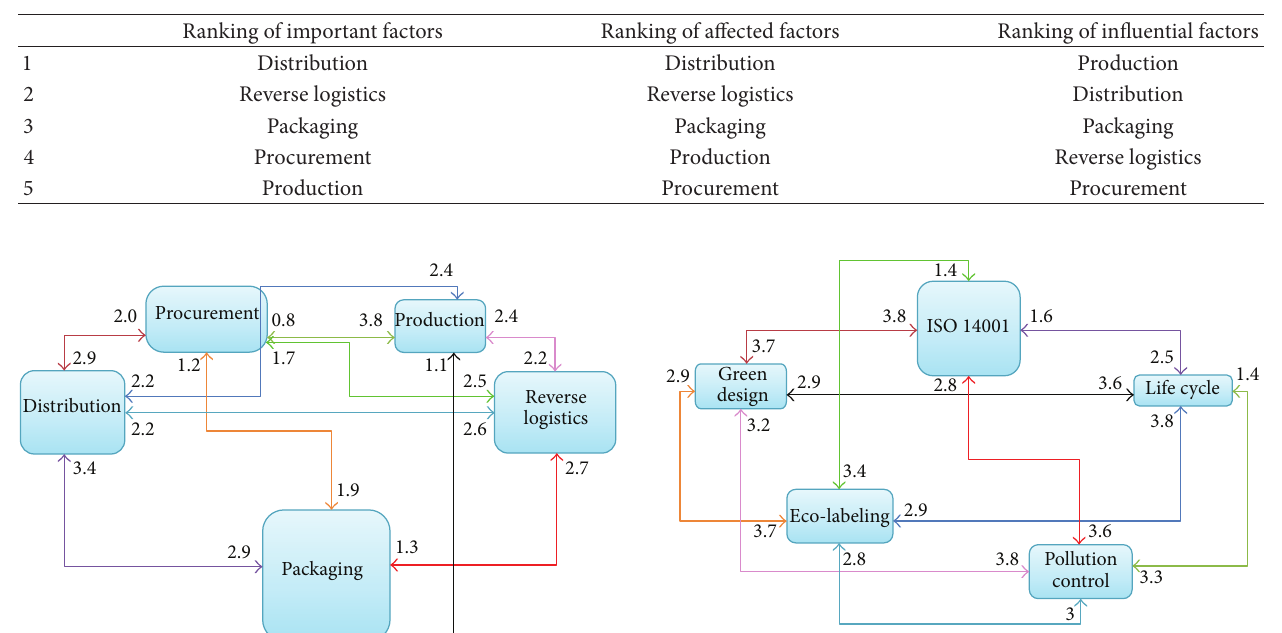
Figure 6: Graphical initial direct impact relation inside green